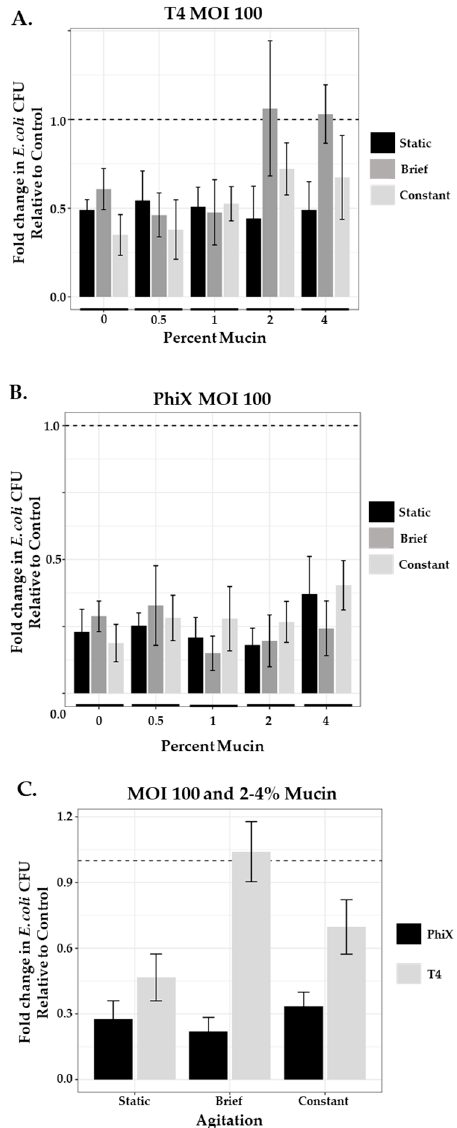
Figure 4. Phage predation with increased MOI of 100 is unique to each phage. Comparison of fold change in bacterial growth in static (black bars), briefly agitated (dark gray bars), and constantly agitated (light gray bars) in-tube samples of varying mucin concentration (0%–4%) treated with MOI 100 of either ( A ) T4 or ( B ) PhiX. ( C ) Comparison of combined 2% and 4% PhiX (black bars) and T4 (gray bars) means as a function of agitation. Columns (means with 95% CI) are representative of the fold change in E. coli growth relative to controls (normalized to 1, represented by dashed line). N ≥ 6 for all